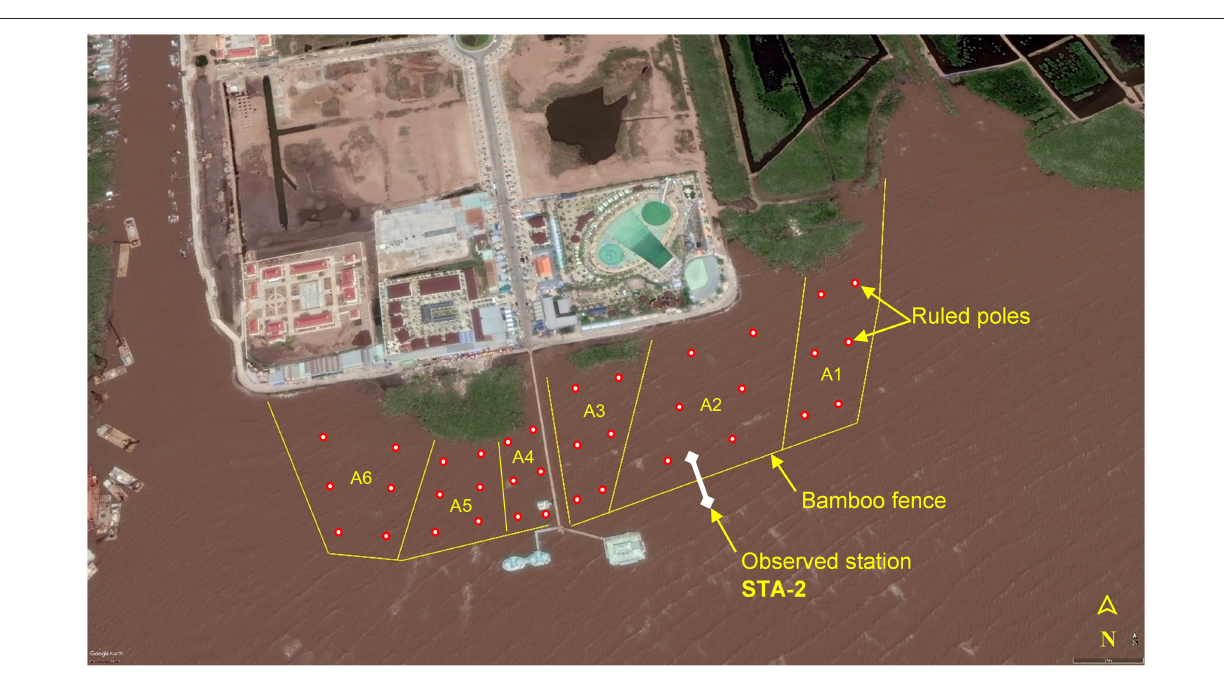
FIGURE 3 | Locations of the wave observing station (STA-2) and the sedimentation areas A1-A6 at the